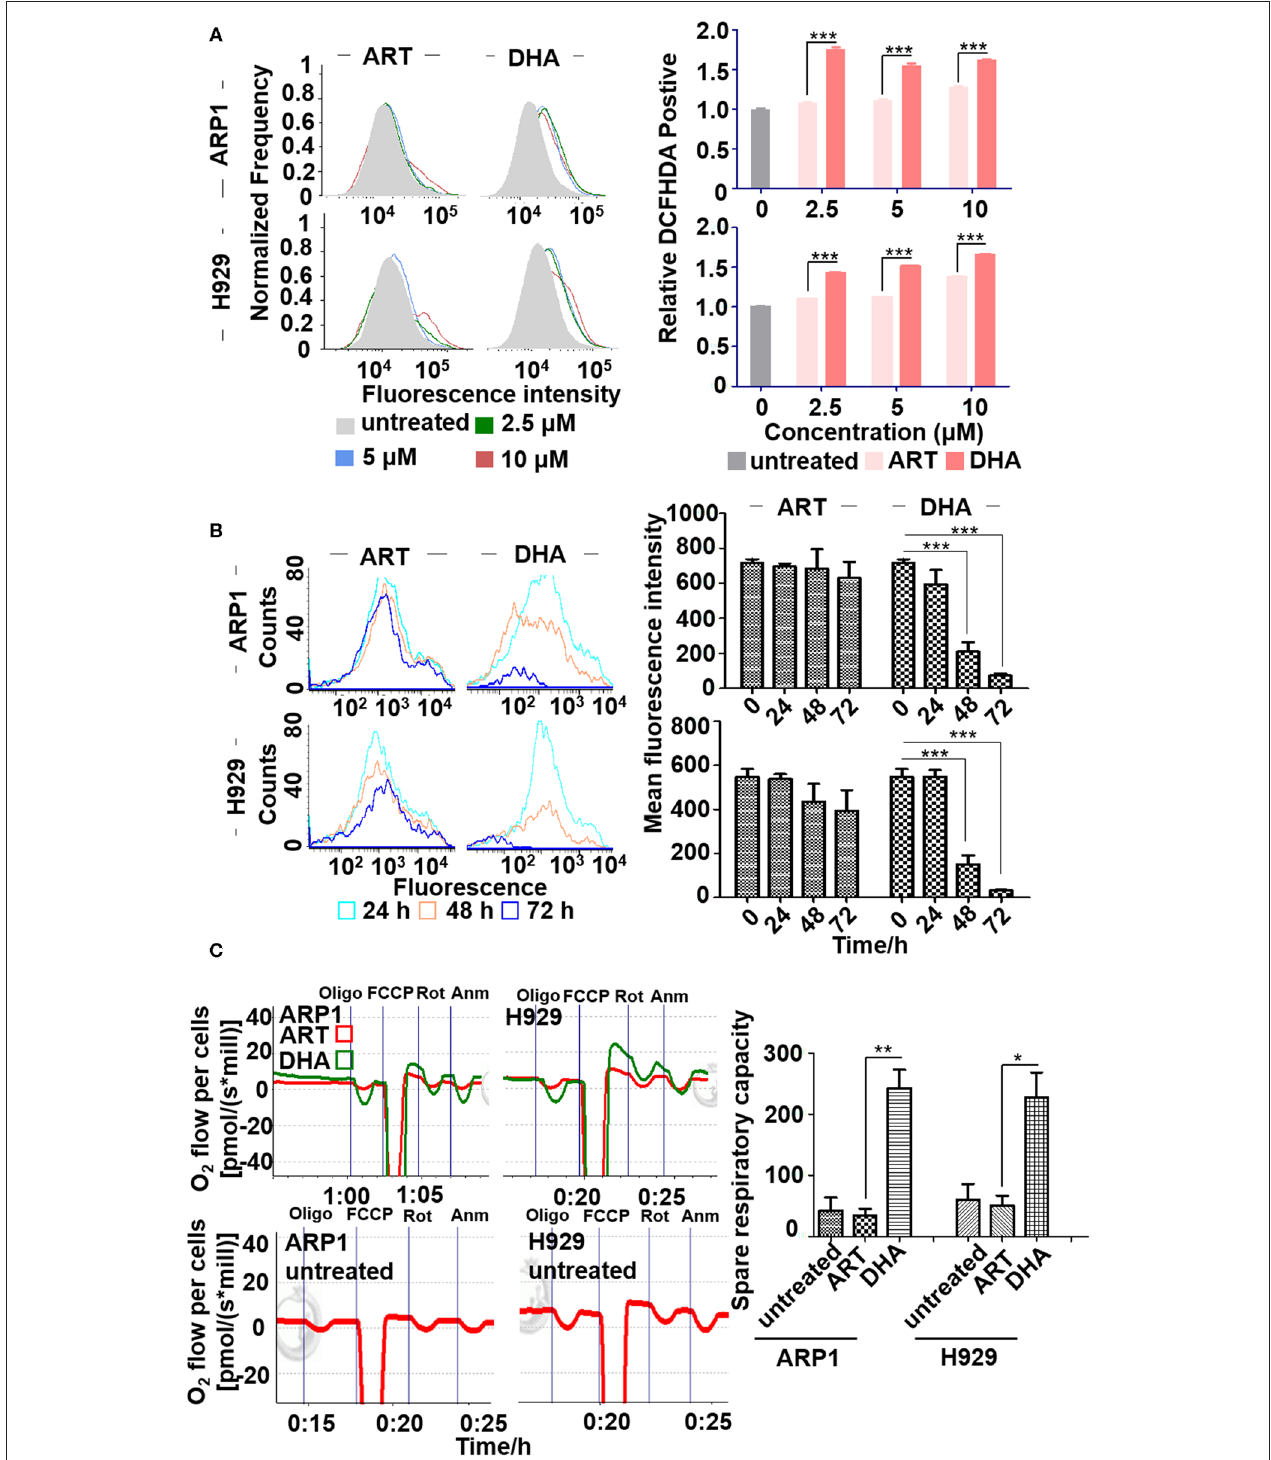
FIGURE 2 | DHA increases the concentration of reactive oxygen species (ROS) in MM cell lines. (A) ROS determination assay. ARP1 and H929 cells were treated with different concentrations of ART or DHA for 48h, and the percentage of DCFHDA positive cells was detected by flow cytometry. (B) The measurement of Fe 2 + levels. Mean fluorescence intensity of ARP1 and H929 cells treated with ART or DHA for different time points (24, 48, and 72h) was measured by flow cytometry. (C) The measurement of OCR. The oxygen consumption rate was determined by O2k (see Materials and Methods). Data statistics were analyzed by Student’s t -test. * P < 0.05, ** P < 0.01, *** P < 0.001.